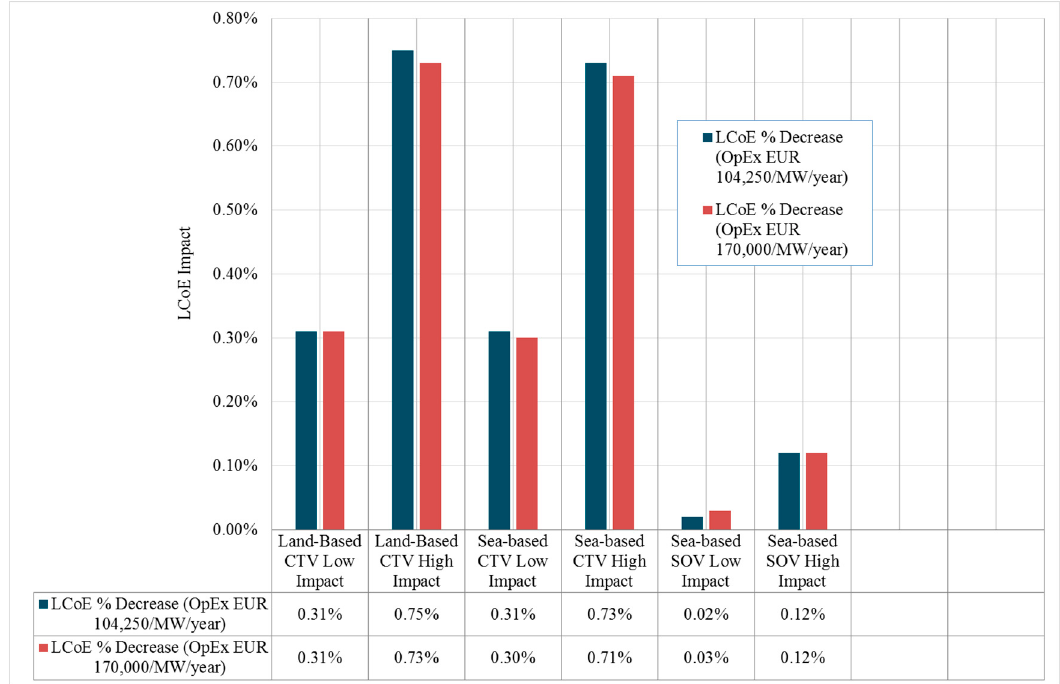
Figure 4. Selected business case impact on offshore wind farm levelized cost of energy.